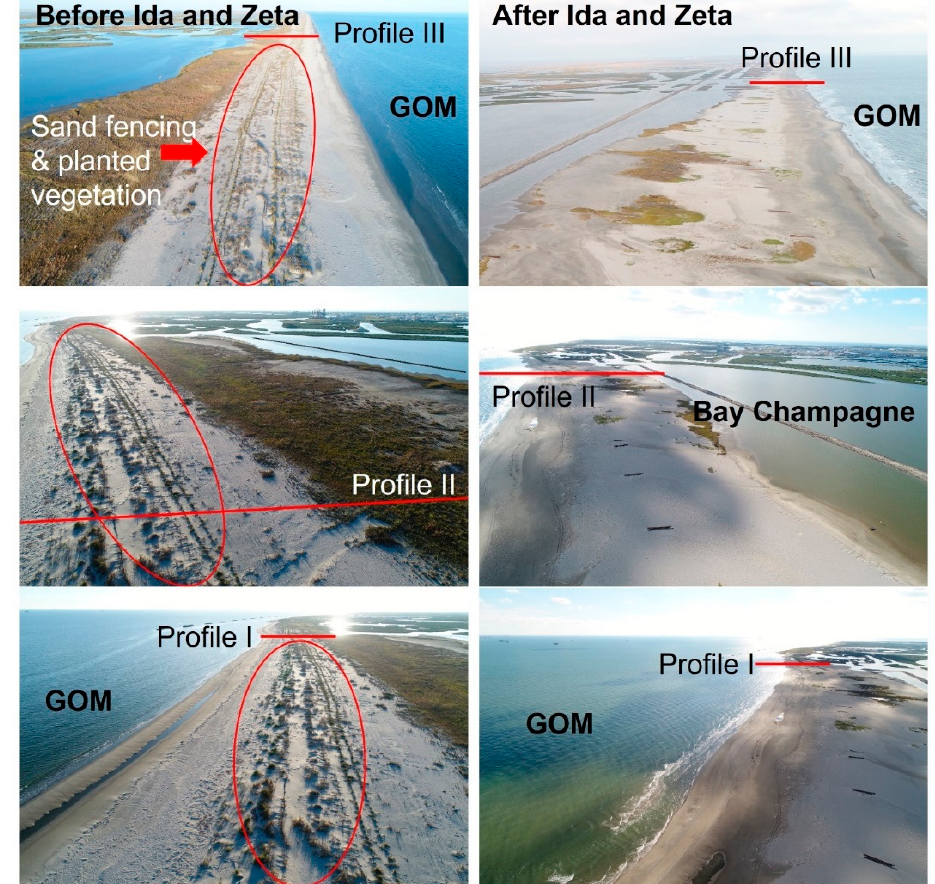
Figure 9. Georeferenced drone images comparing the beach barriers near the three cross-shore profiles before and after Hurricane Ida and Zeta. The red circles mark the sand fences and planted dune vegetation prior to the two hurricanes.